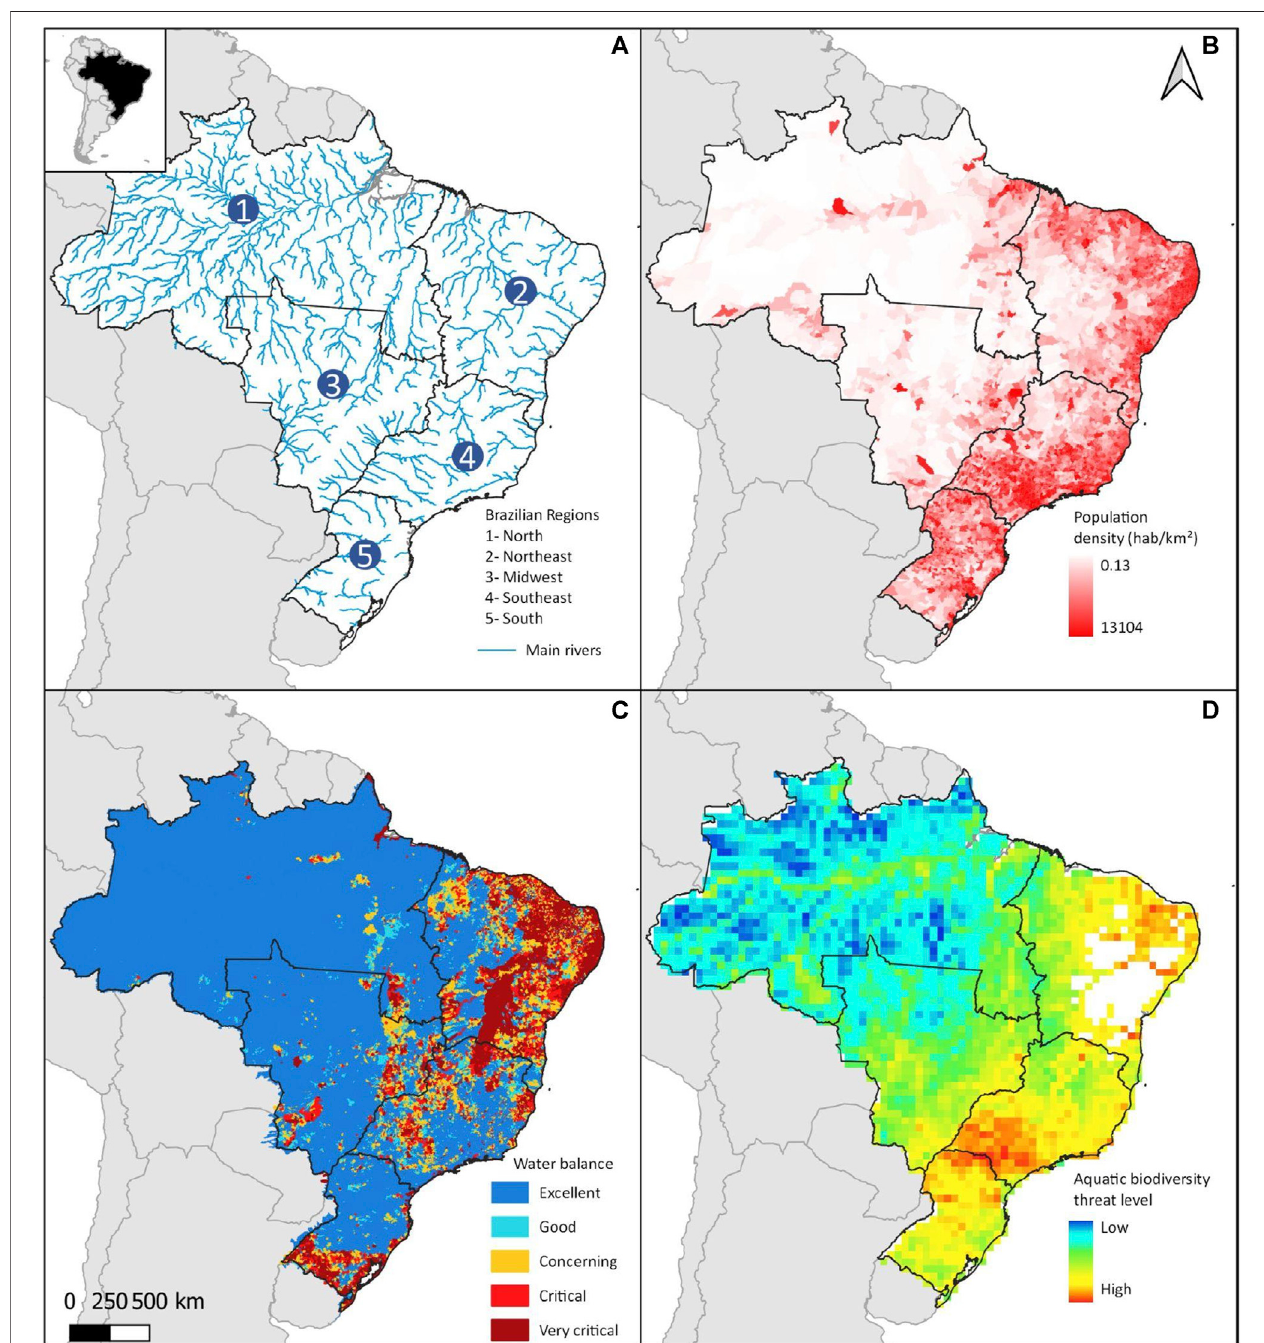
FIGURE 1 | Characterization of the Brazilian geographic regions according to (A) the surface water availability, exempli fi ed by the main hydrographic basins (adapted from ANA, 2021); (B) the population density (people per sq. km of land area; data from the Brazilian Institute of Geography and Statistics - IBGE); (C) the quantitative water balance (adapted from ANA, 2021); and (D) the threat levels to aquatic biodiversity (adapted from Vörösmarty et al., 2010). The quantitative water balance was obtained at the micro-basin scale, through the ratio between the withdrawal for consumptive uses (industry, irrigation, urban supply and livestock watering) and the water availability. The threat levels to aquatic biodiversity in Brazil was based on the global threat index of aquatic biodiversity, which combines 23 stressors according to their impacts on aquatic biodiversity (Vörösmarty et al., 2010). The Brazilian semi-arid region was not considered in this analysis as it is classi fi ed as a desert region (Vörösmarty et al., 2010). About 40% of the Brazilian territory showed threat levels from moderate to high.